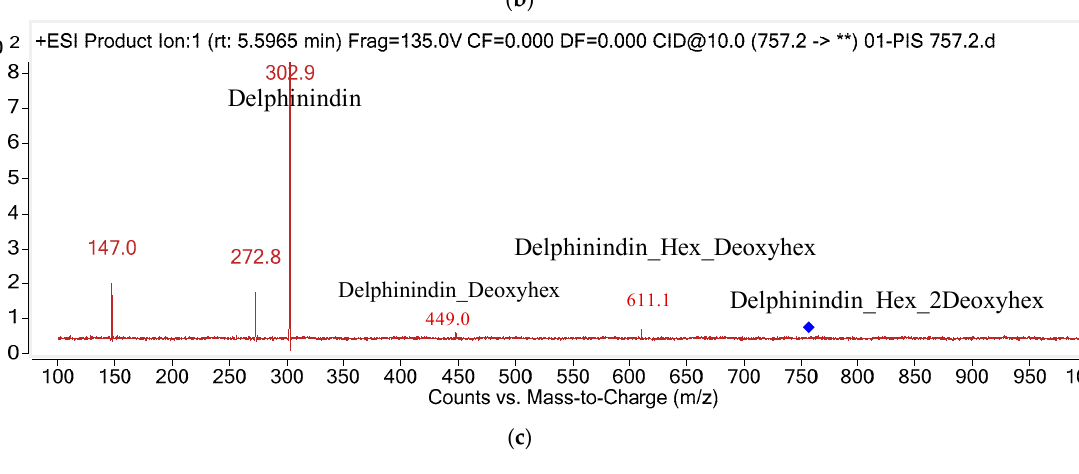
Figure 3. The ion chromatograms ( a ) and ion spectra ( b ) and MS/MS fragments (**) of parent mass 757.2 ( c ). Showing a similar signal to the positive ion analysis, the negative ion electrospray tandem mass chromatogram and the spectrum of the second anthocyanin are shown in Figure 4. Compound 2 exhibited a molecular ion [M + H] + with m / z 741.1 and produced a major fragment with m / z 286.9 that may correspond to cyanidin ( m / z 287). In addition, the m / z transition from 594.9 to 286.9 implied the loss of rutinose ( m / z 308). Thus, with a p-